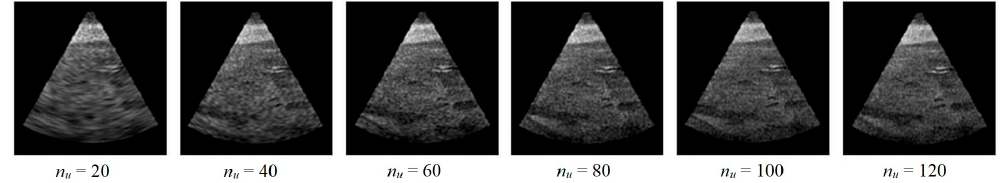
9 of 13 Figure 11. Synthetic images generated using radial polar sampling with a coarse to fine variation of lateral resolution parameter n . The variations of each of the eight components of the feature vector (Equation (6)) computed from the LBP histogram are shown in Figure 12. Figure 12. Variations of LBP feature vector components with lateral resolution in radial-polar sampling. The x -axis gives the values of n . The y -axis gives the range of values of an LBP feature shown in the chart title. In Figure 12, the blue horizontal lines indicate the values of the reference feature vector as given in Equation (7). All components of the LBP feature vector show consistent variations towards the reference values as the value of the lateral resolution parameter n is increased.